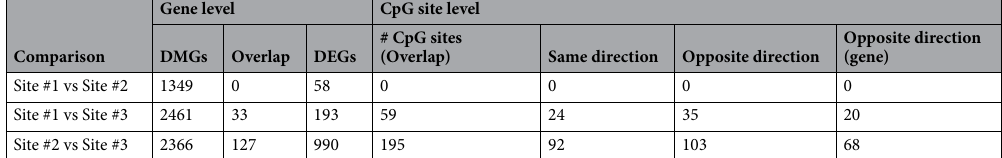
Table 2. Overlap between DMGs and DEGs. Site #1: Legacy Research, Site #2: Trinity College, and Site #3: the University of Alabama at